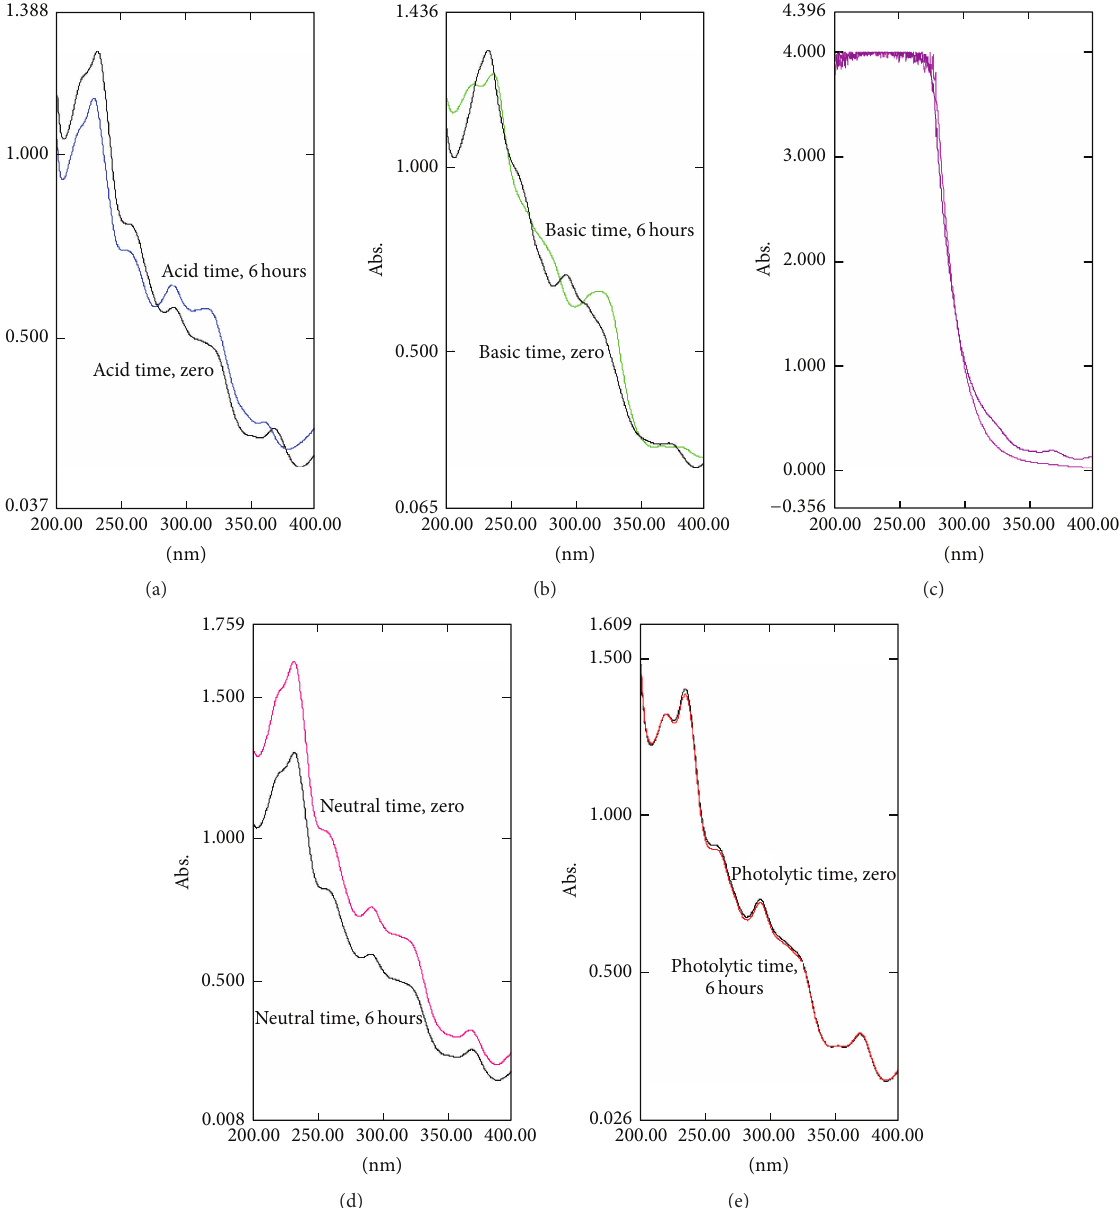
Figure 5: Absorption spectra obtained by absorption spectrophotometric in the ultraviolet region for sample solutions of rifaximin subjected to the following conditions: (a) acid, (b) basic, (c) oxidative, (d) neutral, and (e) photolytic at a concentration of 22 𝜇 g mL −1 .